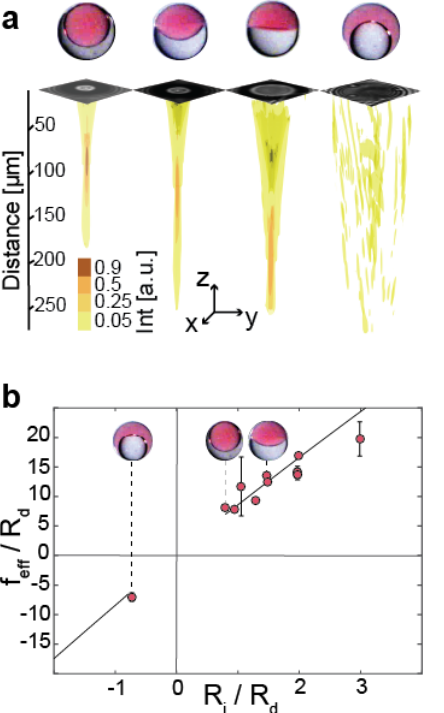
Fig. 2. a) Iso-surfaces of the reconstructed light fields behind the bi-phase droplets for different morphologies. b) Effective focal length as a function of internal radius of curvature Ri, normalized by the droplet diameter Rd.